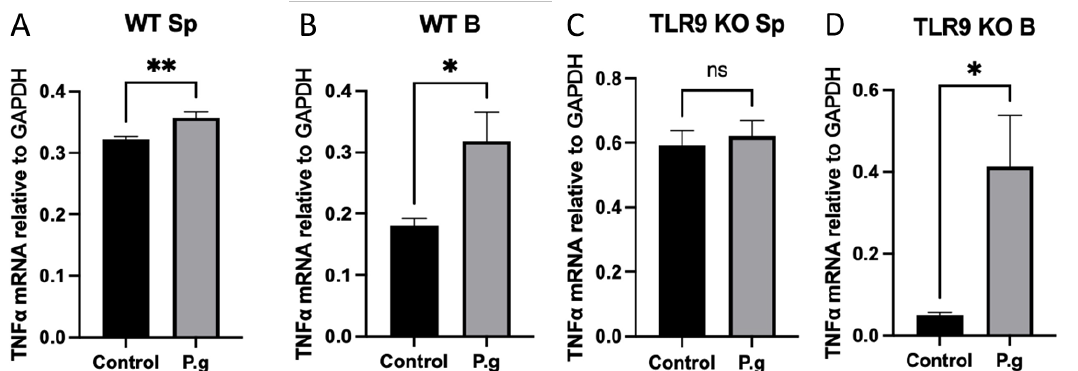
Figure 4. Under P. gingivalis stimulation for 24 h, the IL-10 mRNA level of splenocytes and B cells isolated from both wild-type and TLR9 knockout pre-immunized mice were calculated. ( A ) Splenocytes from wild-type mice; ( B ) B cells from wild-type mice; ( C ) Splenocytes from TLR9 knockout mice; ( D ) B cells from TLR9 knockout mice. The data were shown as mean ± SD; significance calculated by unpaired t -test was indicated as * p < 0.05, ** p < 0.01, and ns (no significant difference) as p > 0.05 (n = 5).